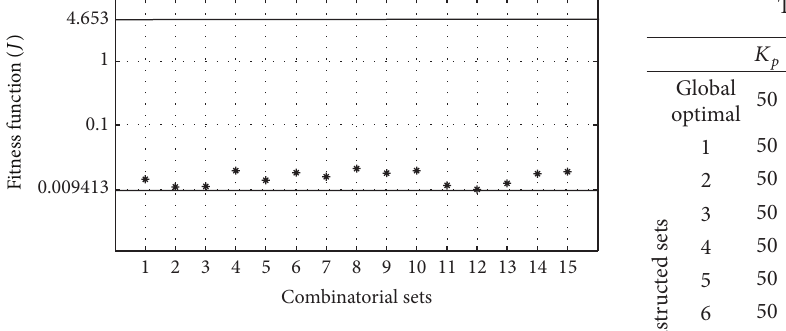
Figure 5: Optimal fitness function values of each optimal PID parameter combination corresponding to each constructed set.